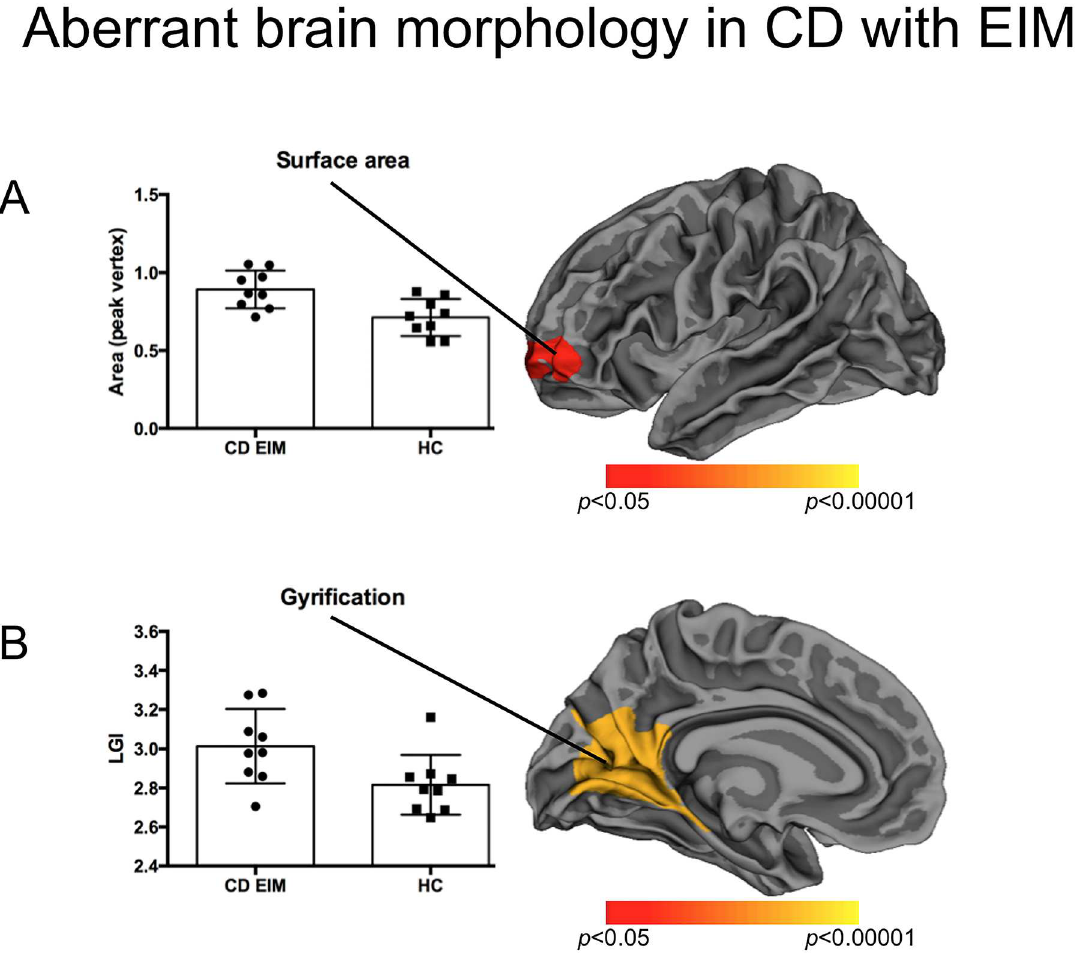
Fig 1. Aberrant brain morphology in CD with EIM. Cortical statistical maps showingleft-hemispheric increasedsurface area (A) and folding(B) in patients with extraintestinal manifestation when compared with controls (p-values corrected for multiple comparisons, vertex-wise analysis over the entire cortical mantle).